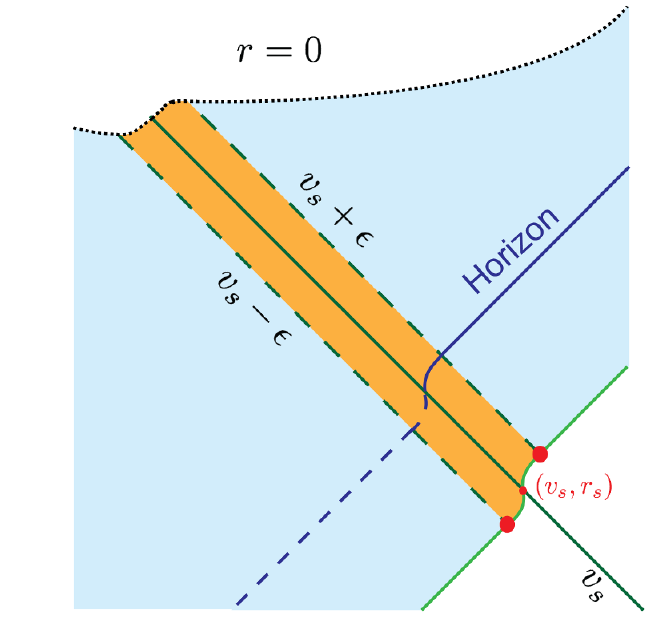
Figure 1 . The null shell has a (cid:12)nite thickness 2 " around the null ray v = v by the WDW patch is shaded in orange. The contribution of the two joints indicated by red dots exactly cancels the surface term for the portion of the null boundary connecting the joints, where we have a time dependent (cid:20) ( v